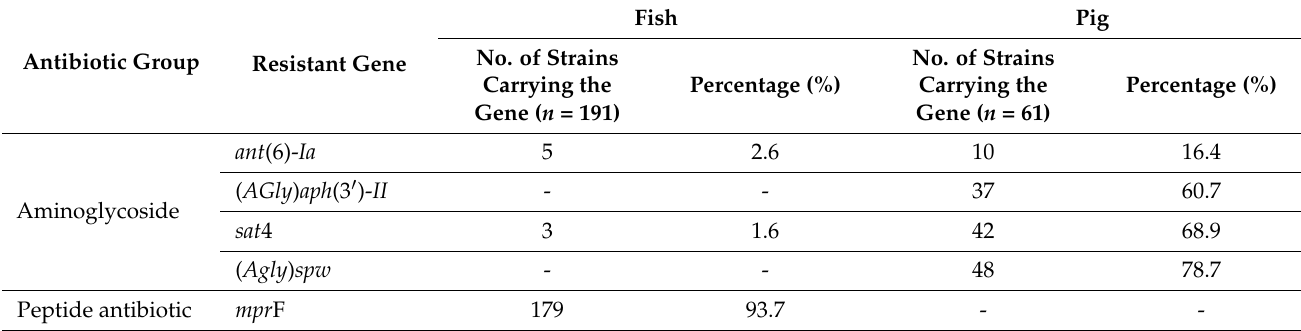
Table 5. Antimicrobial-resistant genes available among fish and pig